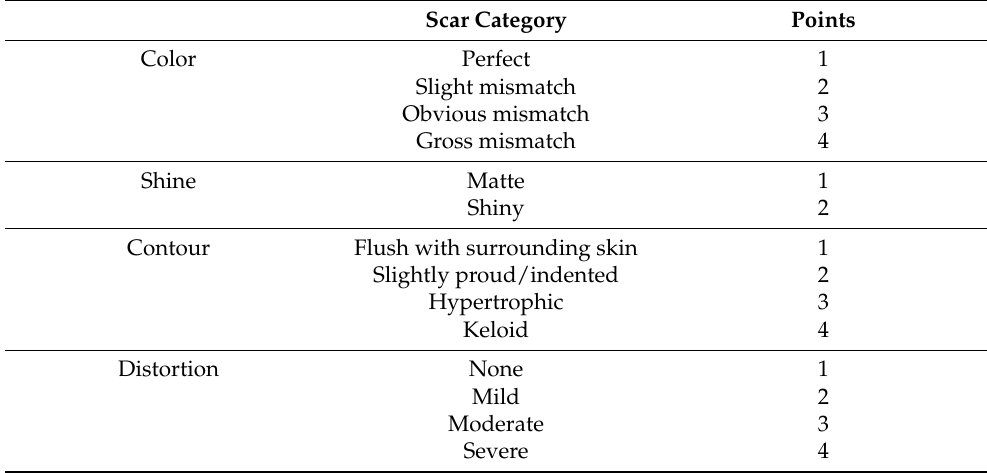
Table 1. Manchester Scar Scale.